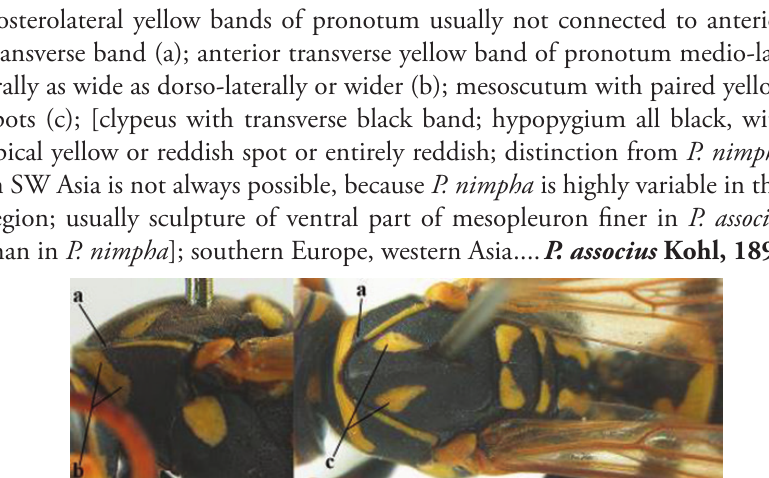
– Posterolateral yellow bands of pronotum usually connected to anterior trans- verse band (aa); anterior transverse yellow band of pronotum medio-laterally narrower than dorso-laterally (bb); mesoscutum sometimes lacking